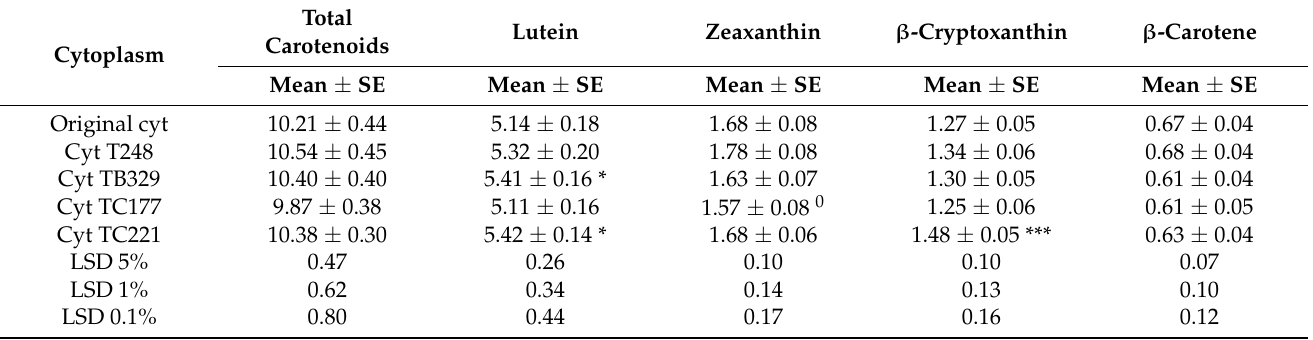
Table 4. Cytoplasm influence on the carotenoid content of the hybrids ( µ g/g)—ANOVA